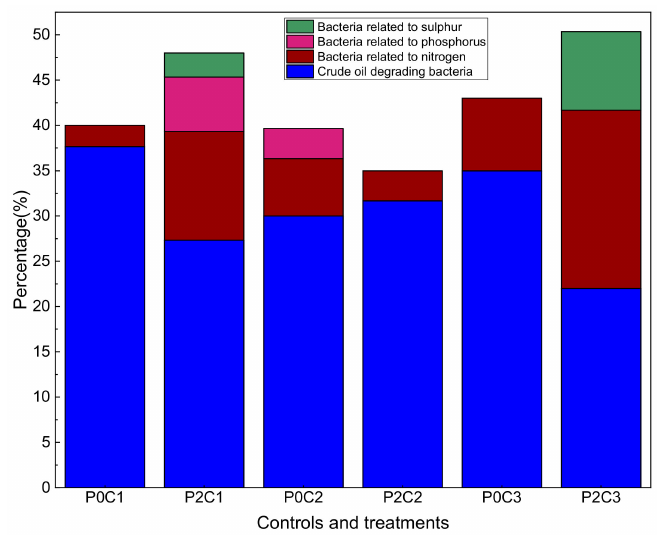
Figure 4. Functional groups distribution in the controls and treatments.